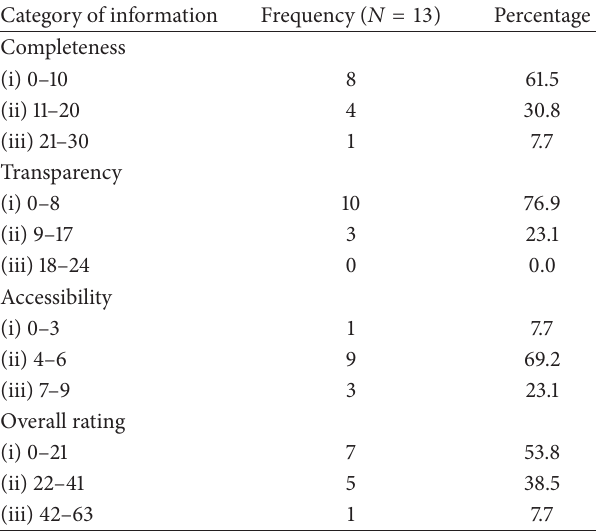
Table 4: Details of breast cancer information.